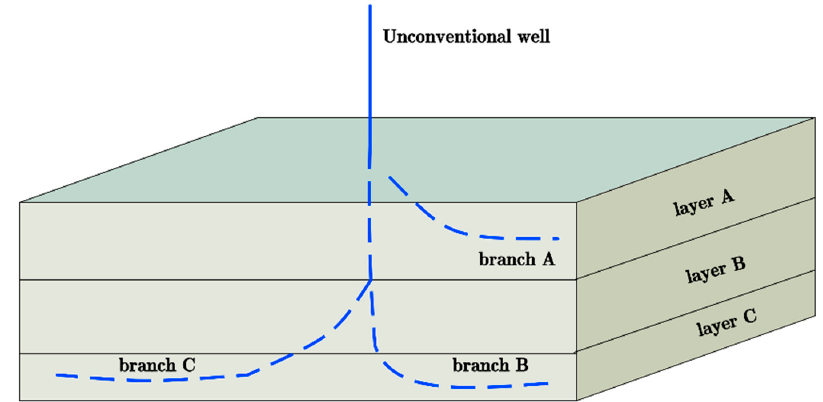
Figure 3. Schematic diagram of reservoir layering in semi-analytical model. Table 1. The method of discretization for different unconventional